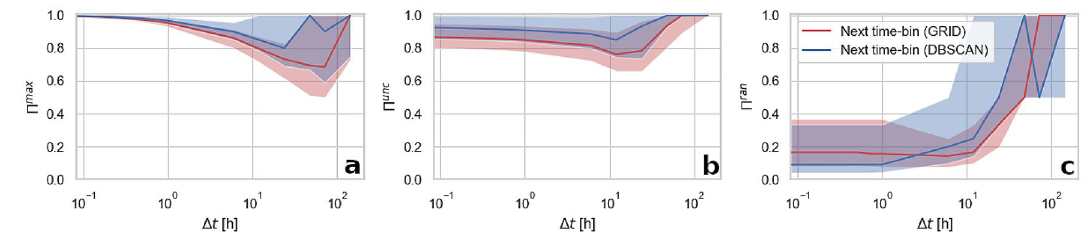
Figure 2. An impact of temporal resolution of data on the three types of predictability (actual ( a ), uncorrelated ( b ), and random ( c ) in the next time-bin sequences). The lines represent the median value and the shaded area indicate the interquartile range of predictability measures calculated for all the users in the dataset.